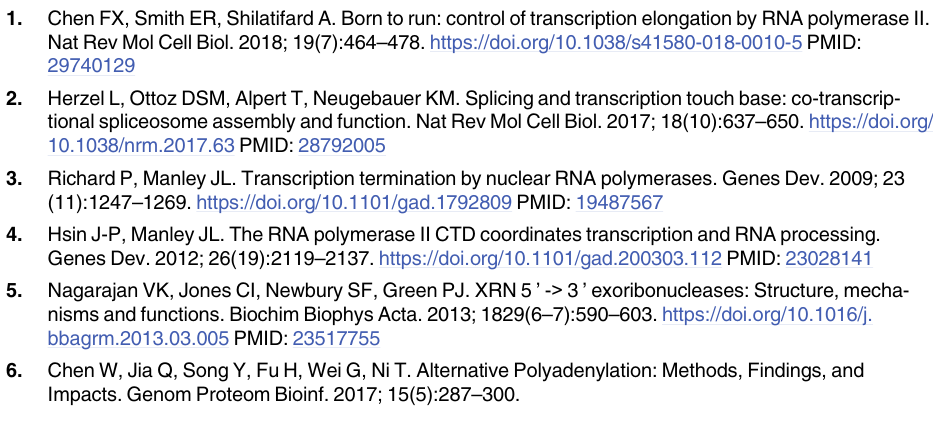
S1 Table. List of oligonucleotides used in this study.